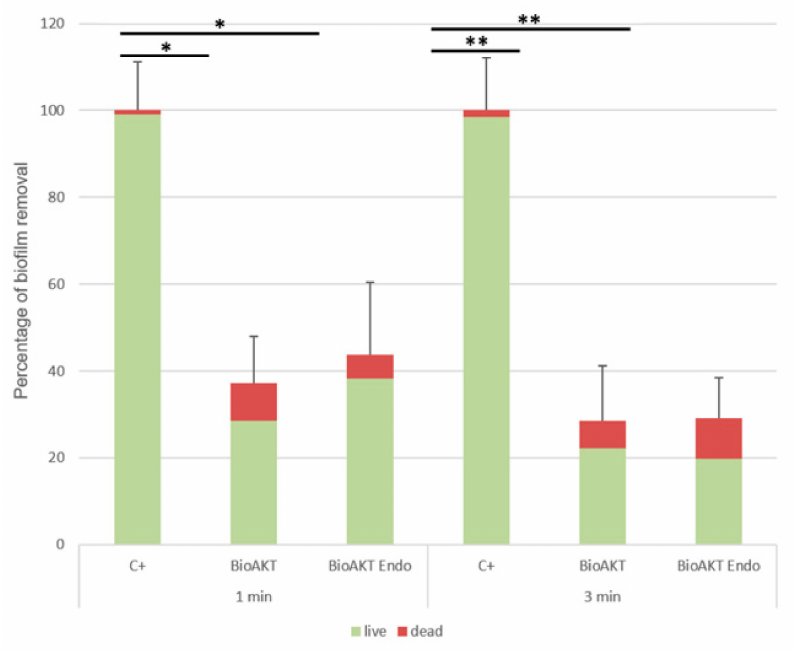
Figure 2. Biofilm removal e ffi cacy of the tested solutions on pre-formed E. faecalis biofilm analyzed by C.L.S.M. Residual biomass is represented in percentage upon treatment concerning the control. Whole bars represent the total biomass; the green fraction is viable cells, in red the dead cells still encased in the biofilm. * p < 0.05, ** p <